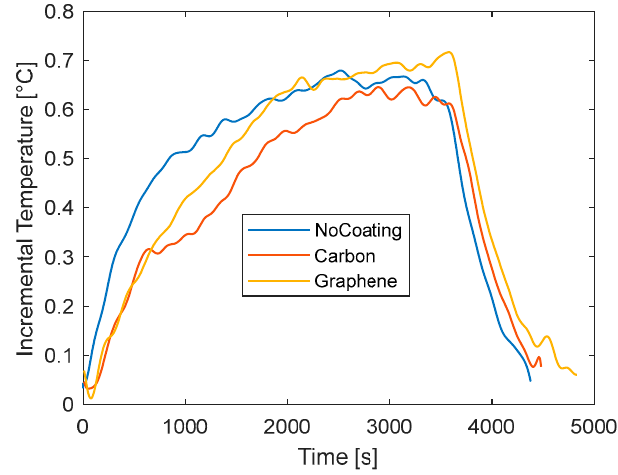
Figure 7. Curves of temperature versus time for different coatings for discharge tests at 0.5C. Table 4. NRMSE between the curve of temperature for the uncoated and coated battery at discharge rate 0.5C.